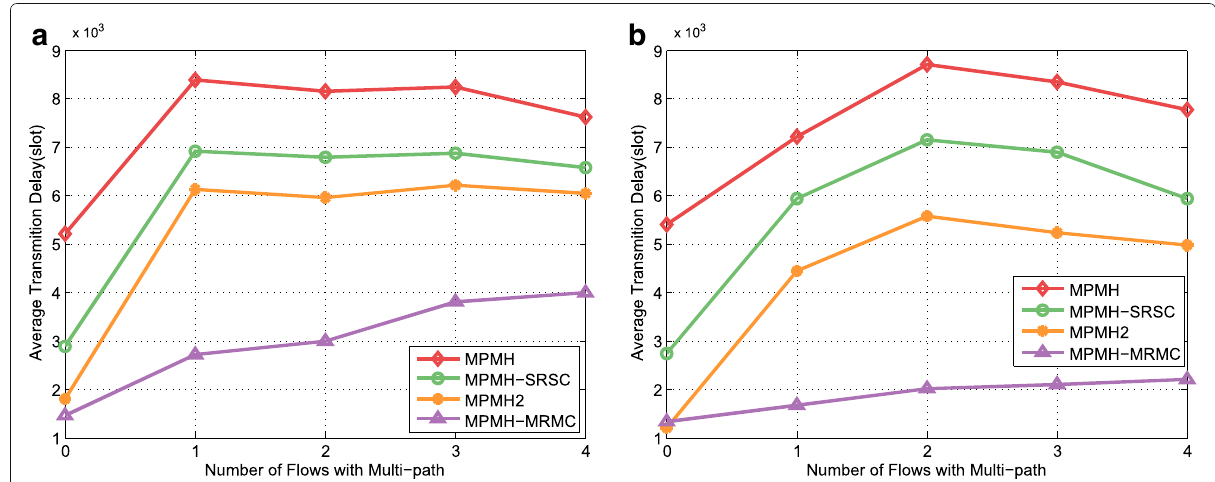
Fig. 8 Average transmission delay of the four MAC protocols under a different number of flows with multi-path. a Traffic load ratio is 25 with